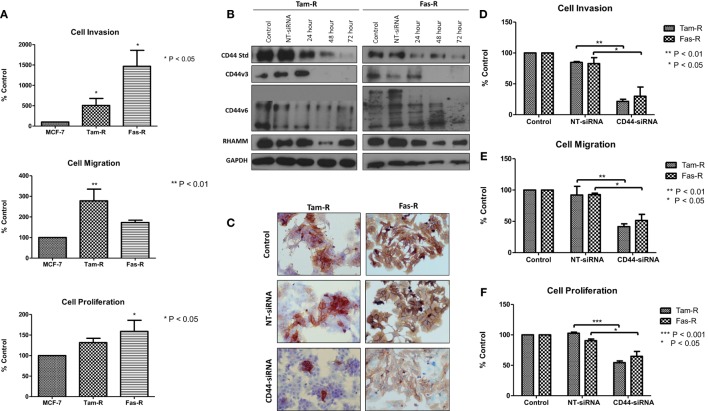
siRNA-mediated CD44 suppression reduces the aggressive behavior of endocrine-resistant breast cancer cell models. (A) Tam-R and Fas-R cells display enhanced migratory, invasive, and proliferative capacity compared to MCF-7 cells. (B) Western blotting demonstrated that treatment of Tam-R and Fas-R cells with CD44-siRNA resulted in suppression of CD44s, CD44v3, and CD44v6 isoforms and global CD44 loss was confirmed by immunocytochemistry (C). Suppression of CD44 expression subsequently resulted in loss of invasive (D), migratory (E), and proliferative responses (F) in Tam-R and Fas-R cells.